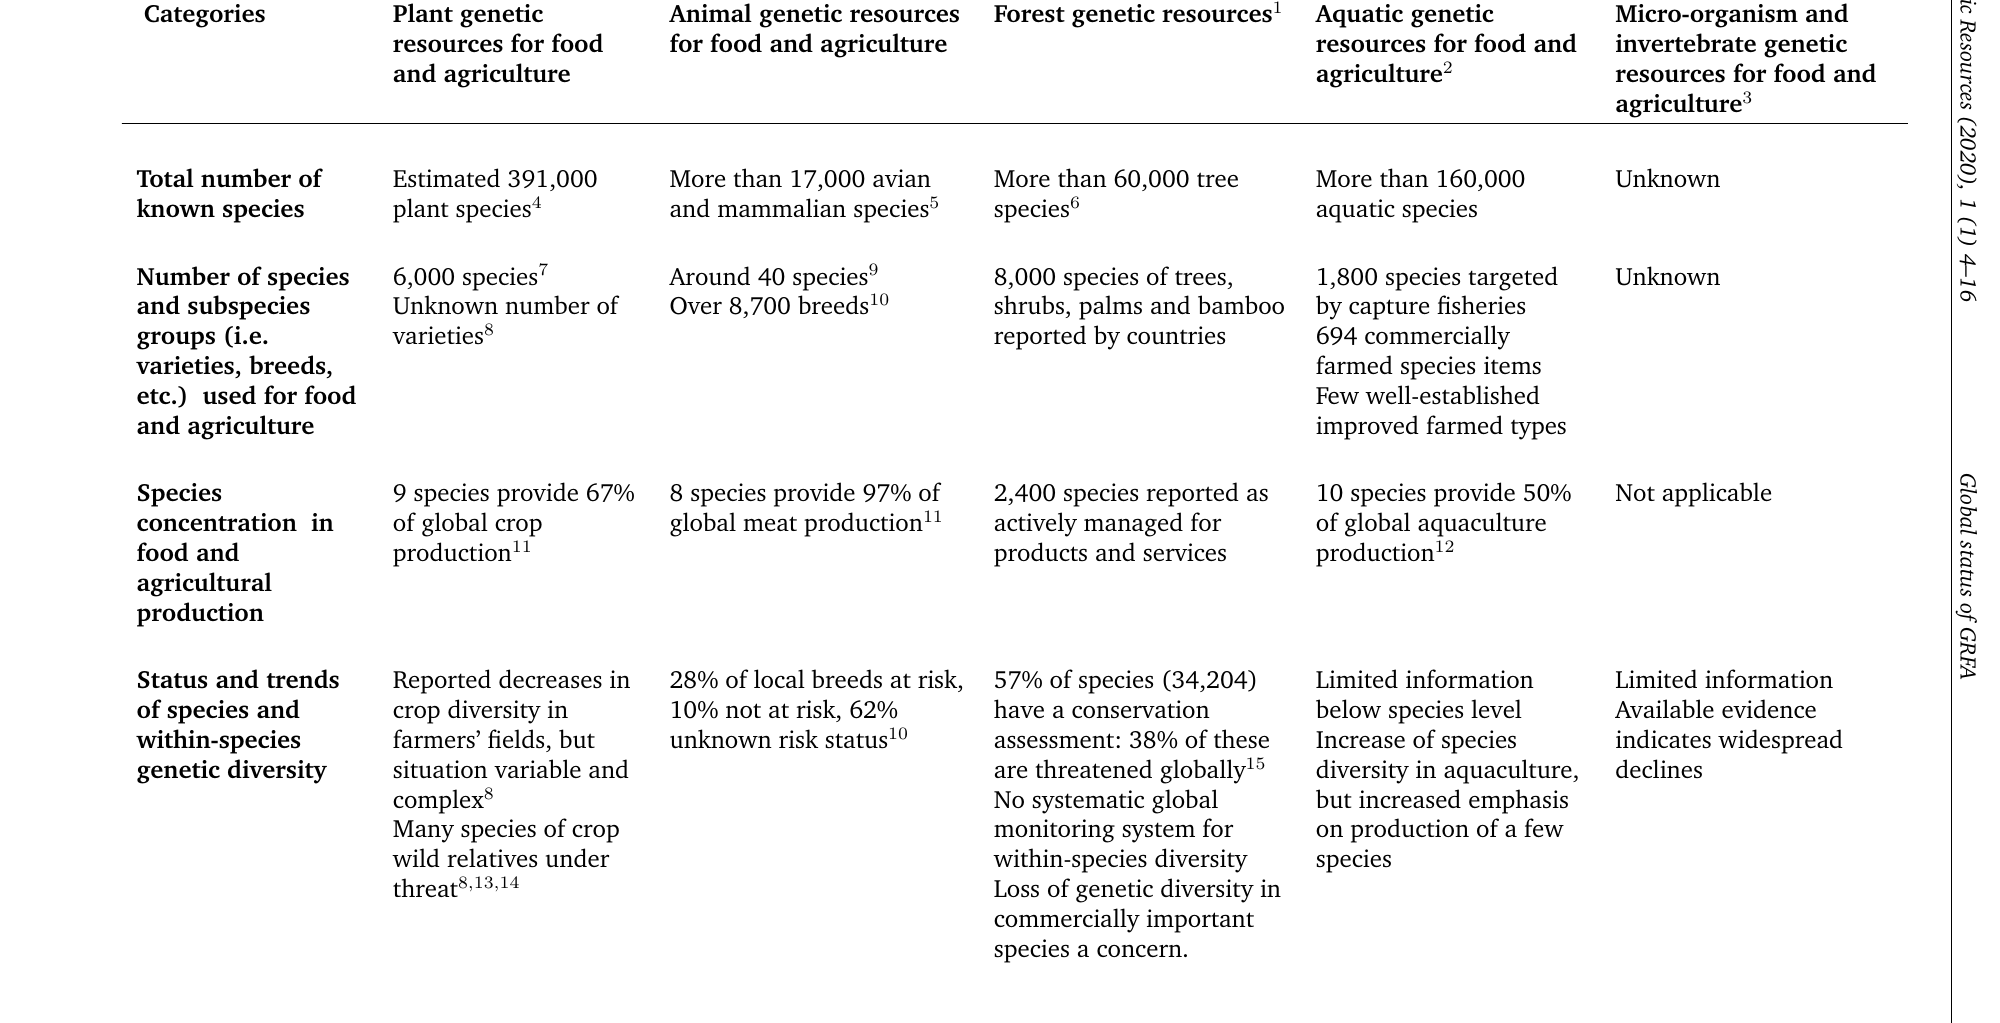
Table 1. Selected facts and figures on the state and trends of genetic resources and their management at global